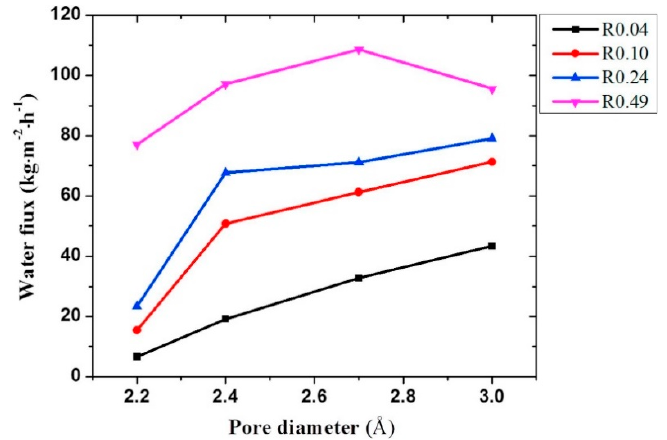
Figure 13. Water flux across GO monolayer membranes based on variable pore diameter and O/C ratio